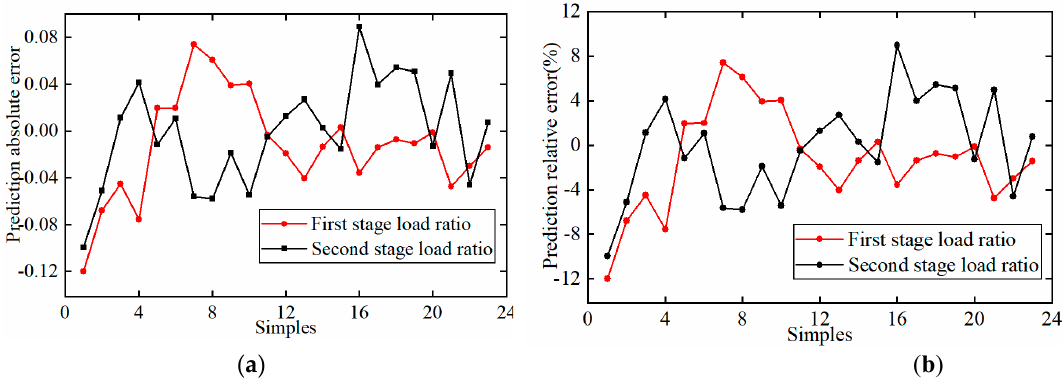
Figure 19. ( a ) Prediction absolute error of conventional ANN model; ( b ) relative prediction error of conventional ANN model.